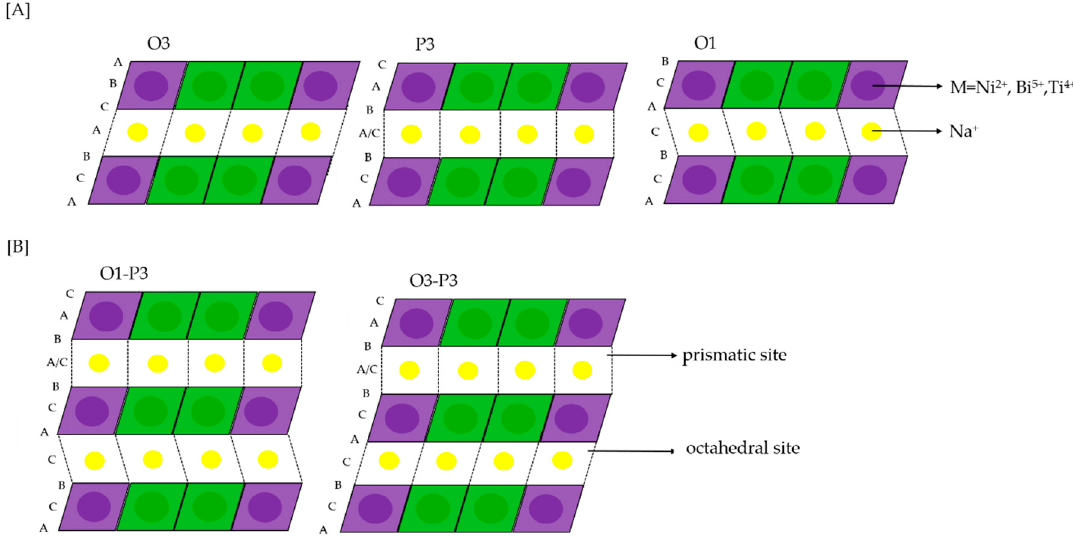
Figure 1. Stackings of O3 (AB CA BC-type), P3(AB BC CA-type) and O1 (AB-type) structures [ A ] and corresponding hydrids of O1-P3 and O3-P3 [ B ] [10].